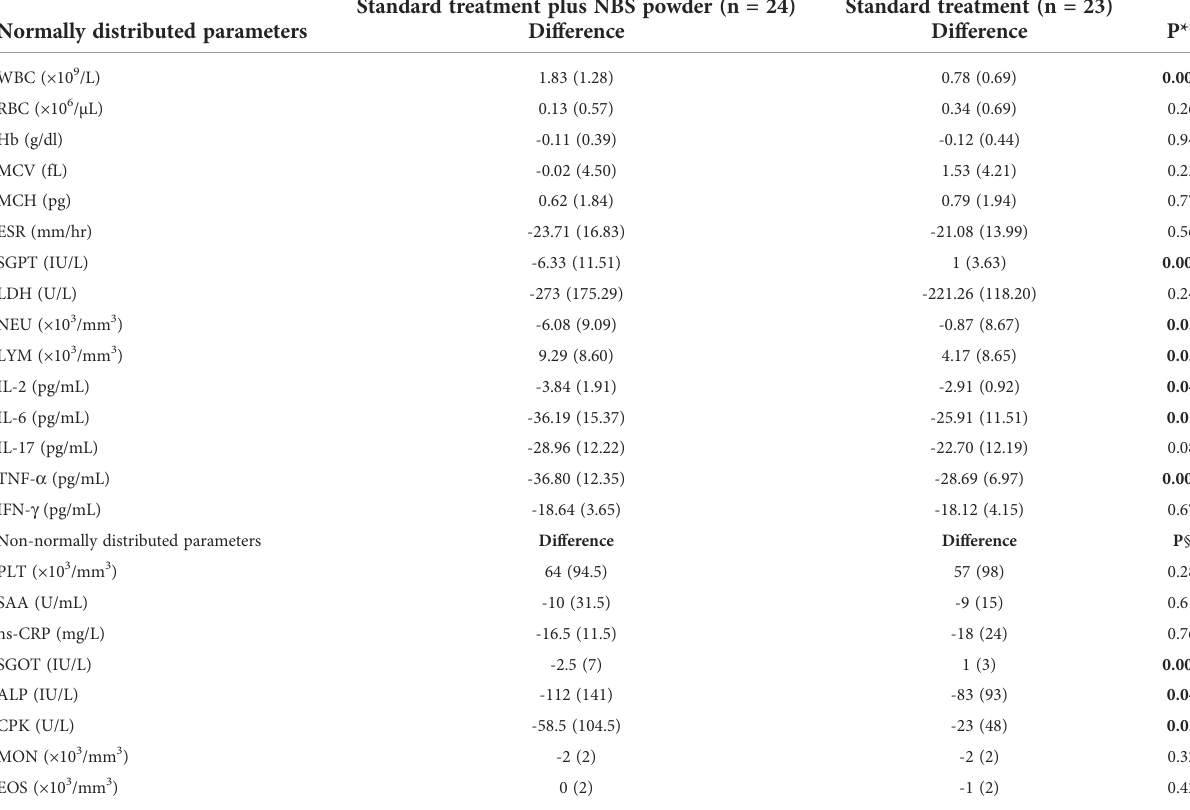
TABLE 3 Comparing of difference in level of parameters between the intervention and control groups at the end of follow